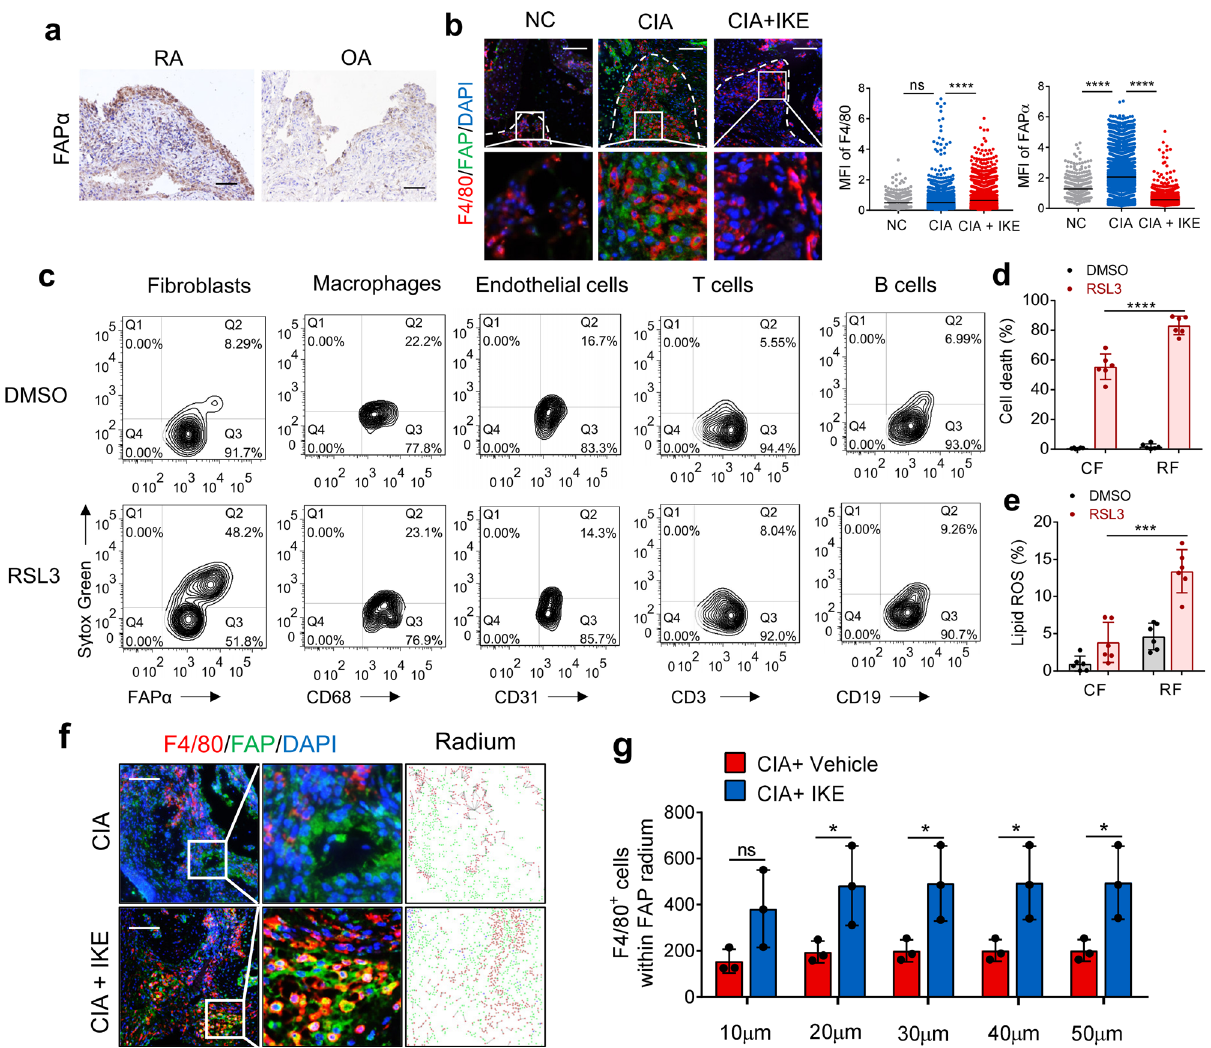
Fig. 2 The ferroptosis inducer IKE decreased fi broblast populations in RA synovium. a Representative immunohistochemical staining of FAP α in hyperplastic rheumatoid synovium of 26 RA and 21 OA patients. Scale bars, 50 μ m. b Representative fl uorescent multiplex IHC staining and scoring of joints labeled with anti-F4/80 (red), anti-FAP α (green), and DAPI (blue). Scale bars, 100 μ m. n = 413 (NC), 3698 (CIA), 3469 (CIA + IKE) cells from 3 independent joints for each group. **** P < 0.0001; ns, P = 0.6849; one-way ANOVA followed by multiple comparisons. c Cell death in FAP α + fi broblasts, CD68 + macrophages, CD31 + endothelial cells, CD3 + T cells, or CD19 + B cells isolated from hyperplastic synovium treated with 0.125 μ M RSL3 for 6 h, quanti fi ed by SYTOX staining followed by fl ow cytometry. Cell death ( d ) and lipid ROS production ( e ) in circulating fi brocytes from PBMCs and synovial fi broblasts from in fl amed joint fl uid of RA patients treated with 0.125 μ M RSL3 for 18 h (cell death) or 6 h (lipid ROS). **** P < 0.0001, *** P = 0.0001; two- tailed t -test. n = 6 patients. f Representative fl uorescent multiplex IHC staining of retained hyperplasia synovium of CIA model mice treated with or without IKE and labeled with anti-F4/80 antibody (red), anti-FAP α antibody (green), and DAPI (blue). Scale bars, 200 μ m. g The number of F4/80 + macrophages within the 50 μ m radium of FAP α + fi broblasts in joints of CIA mice. * P < 0.05; ns, P = 0.00878; two-tailed t -test. n = 3 joints. Data are presented as mean ± SD. Source data are provided as a Source data fi fi broblasts. Altogether, these data suggest that the existence of fi broblast subsets with distinct ferroptosis sensitivity is probably related to the transduction of TNF signaling from macrophages.